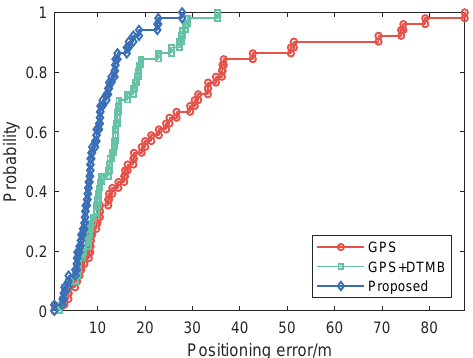
Figure 13. Empirical CDF curves of GPS-only, GPS + DTMB and the proposed method at Site